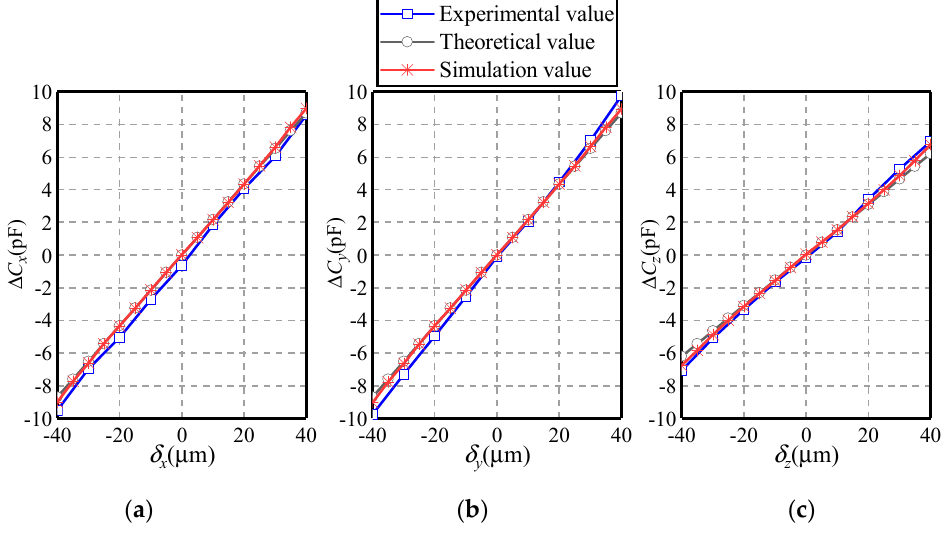
Figure 15 . Dependence of the differential capacitance on the eccentric displacement along the Figure 15. Dependence of the di ff erential capacitance on the eccentric displacement along the X = Y = Z X=Y=Z direction. ( a ) Δ C x , ( b ) Δ C y , and ( c ) Δ C z . direction. ( a ) ∆ C x , ( b ) ∆ C y , and ( c ) ∆ C z